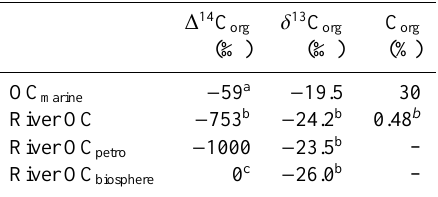
Table 2. Compositions used in the mixing and terrestrial OC loss